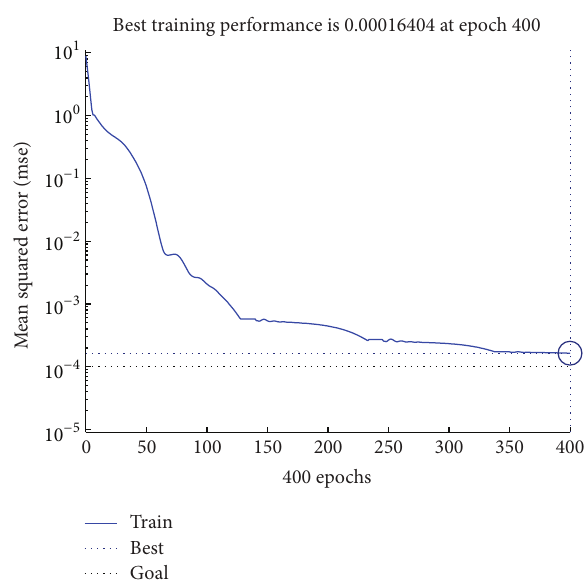
Figure 11: Dropping of deviation by training.